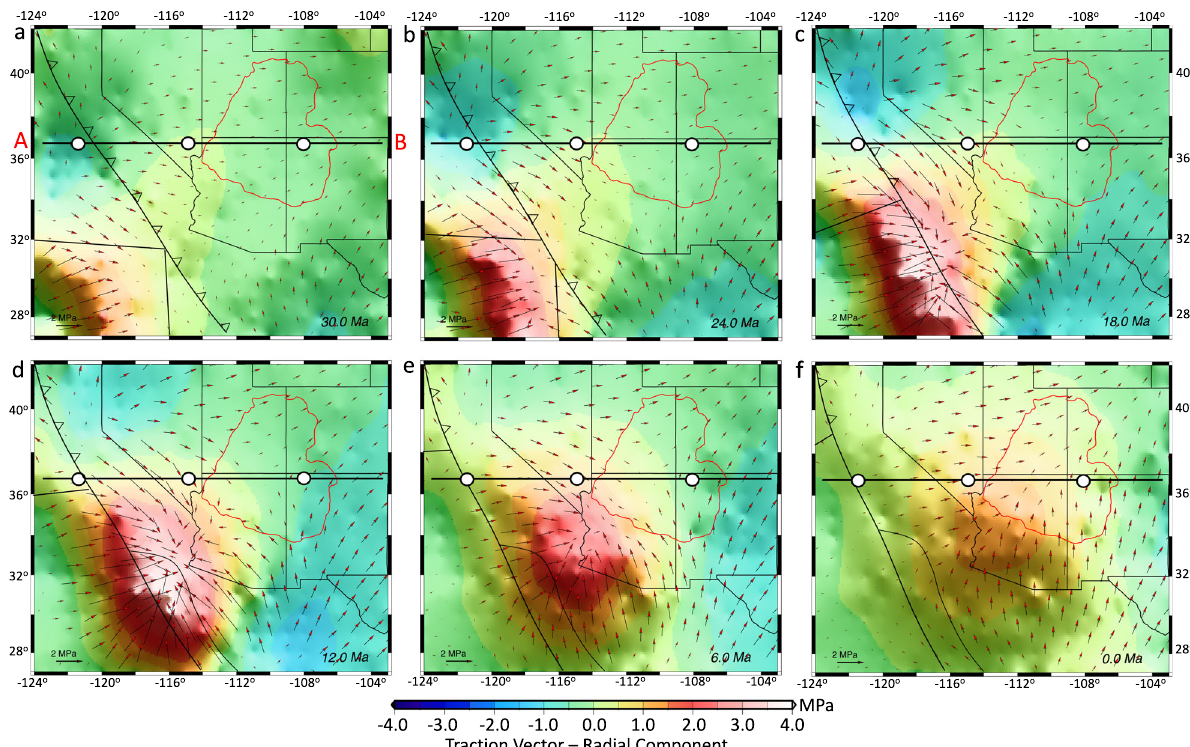
Fig. 4 Evolution of the traction fi eld associated with mantle convection at 200 km depth. a – f Vectors represent horizontal components of the traction vector fi eld at 200 km depth, and contours represent the radial component of the traction vector fi eld at 30, 24, 18, 12, 6, and 0 Ma, respectively. The closed red line indicates the present-day edge of the Colorado Plateau. The map images were created by authors using: www.soest.hawaii.edu/gmt/ and